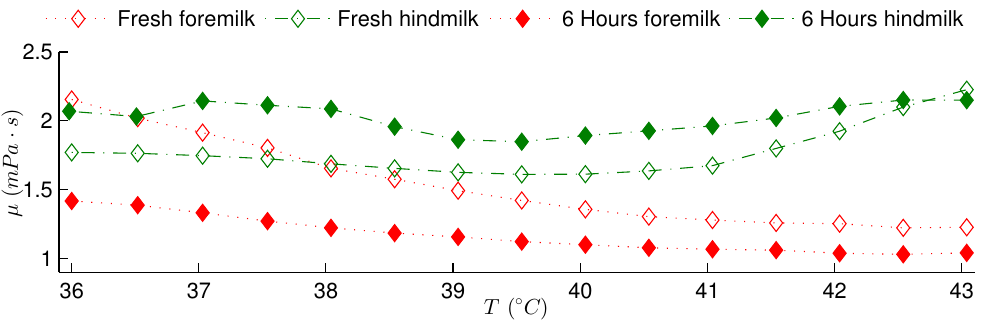
Figure 8. Temperature Sweep Test #3 at ˙ γ = 50 s − 1 shows intra-feed variations in viscosity that relate to composition. Hindmilk consistently has higher viscosity compared to foremilk from the same breast and expression (intra-feed variations). When the samples were aged at 37 ◦ C for 6 h (filled diamonds), the foremilk viscosity decreased slightly while hindmilk increased (see Section 3.5). Samples from Participant